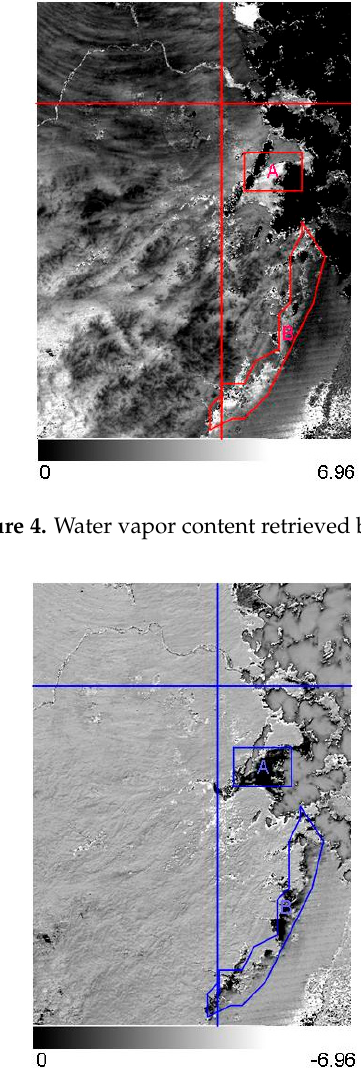
Figure 3. MYD05_L2 product over China.